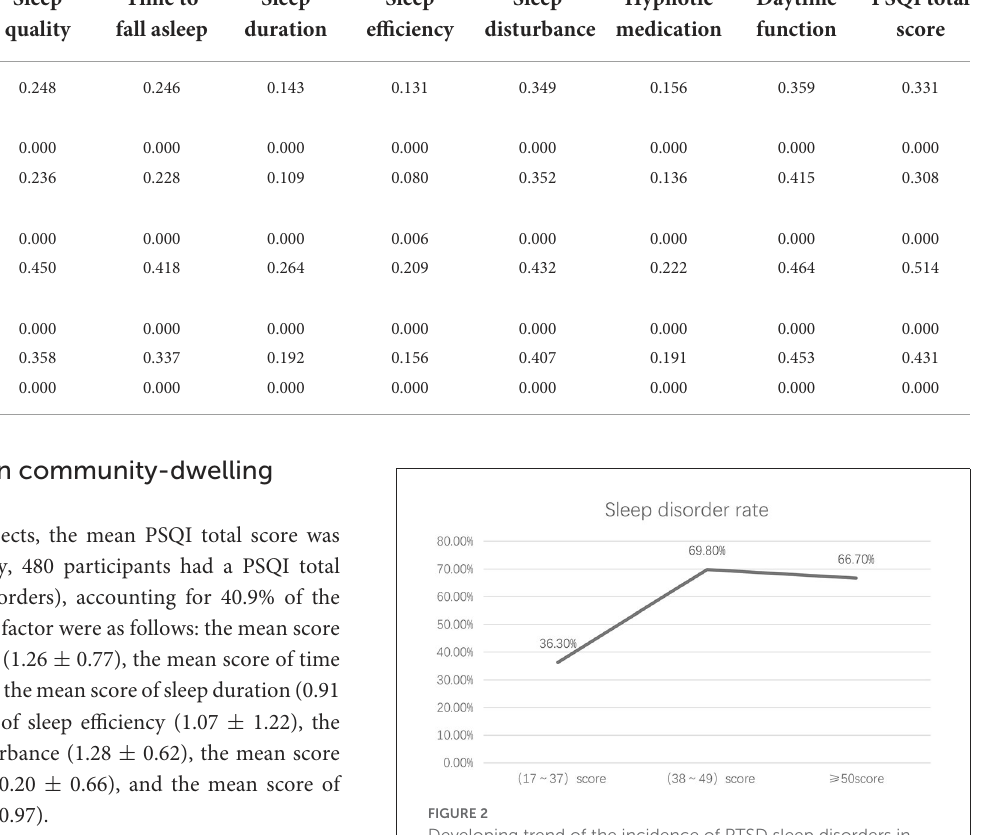
Time to Sleep Sleep Sleep Hypnotic quality fall asleep duration efficiency disturbance medication